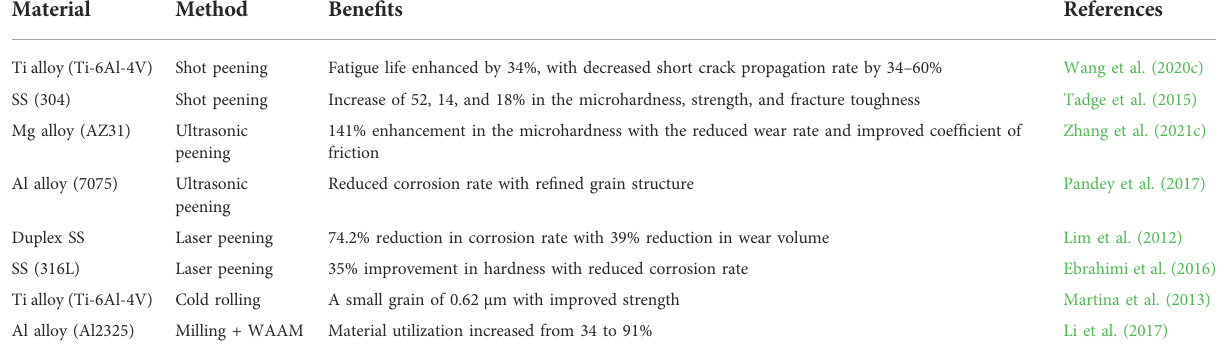
TABLE 1 Bene fi ts associated with different post-processing techniques. Material